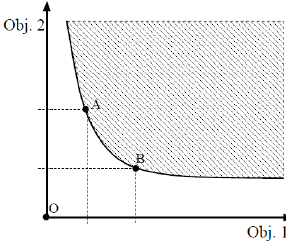
Figure 4. Bi ‐ objective minimization problem. The shaded region presents dominated solutions and solid curve illustrates non ‐ dominated solutions [51].